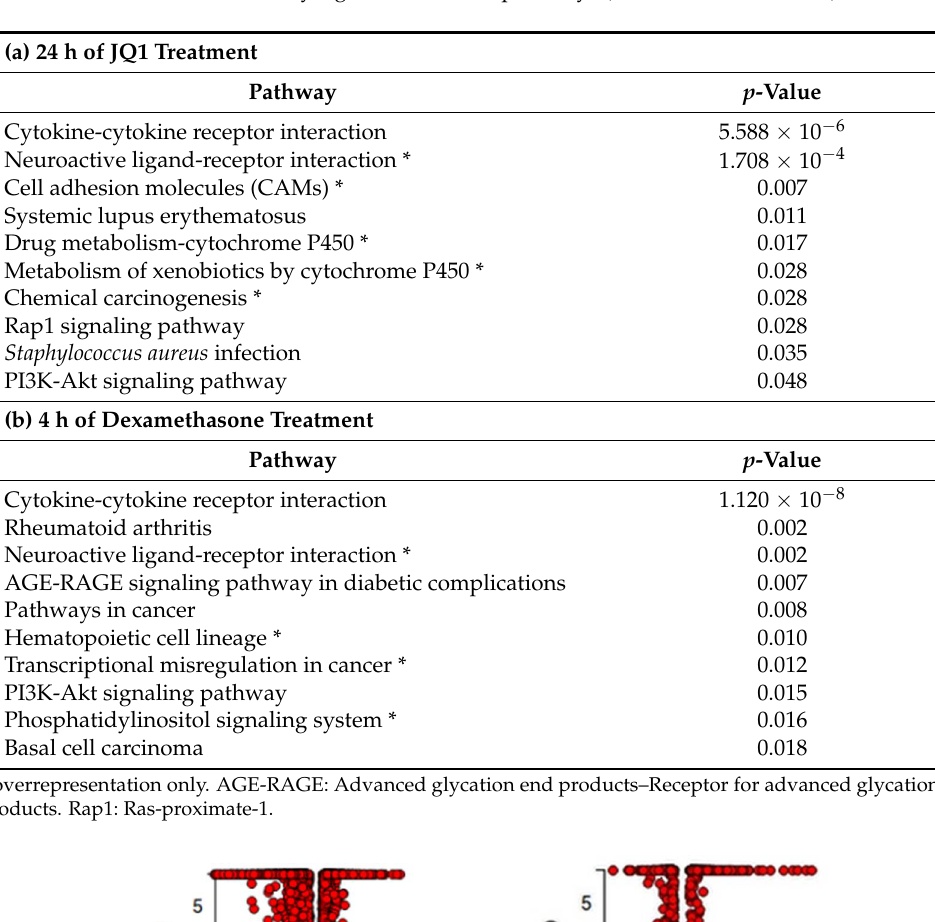
Table 3. Most significantly enriched Gene Ontology (GO) terms for different samples. Table 5. Statistically significant altered pathways (Resistant vs. Sensitive).